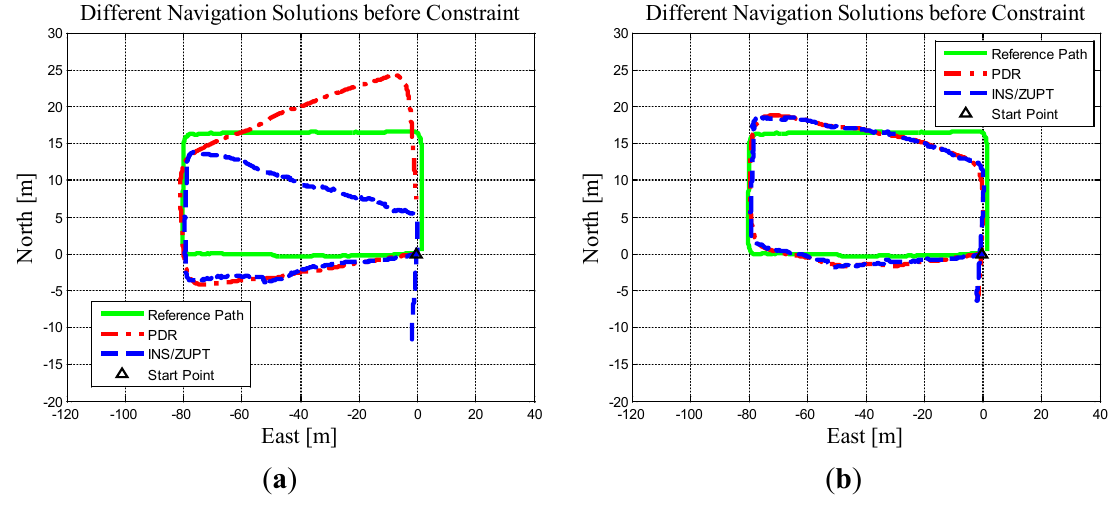
Figure 9. Trajectory II: Two systems’ navigation solutions. ( a ) Before constraint; ( b ) After constraint.